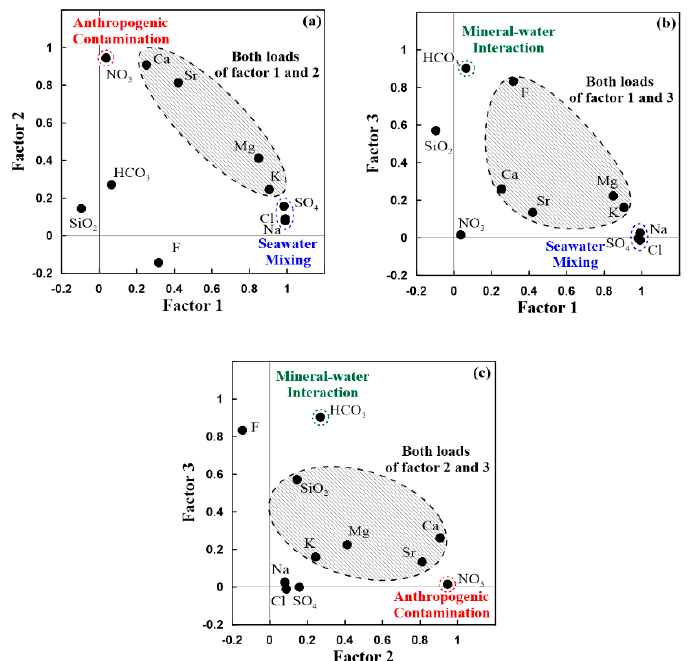
Figure 7. Distribution of variables among factors as produced by factor analysis. ( a ) Factor 1 vs Factor 2, ( b ) Factor 1 vs Factor 3, and ( c ) Factor 2 vs Factor